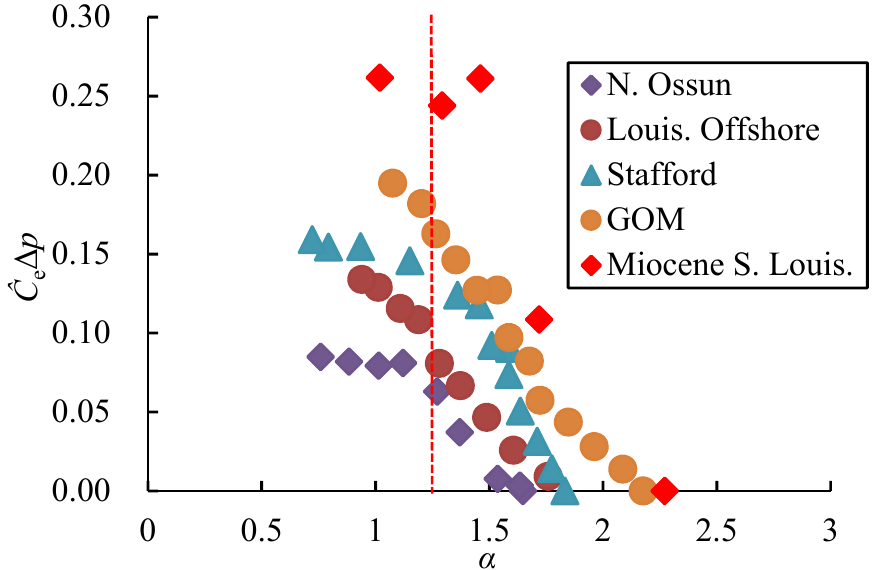
Figure 2. Relationship between the abnormally high-pressure effect and the pressure coefficient. The relationship between ˆC e ∆ p and α shows two different regular patterns in Figure 2: when the pressure coefficient was greater than 1.2, ˆC e ∆ p significantly changed with α and showed a good linear negative correlation (refer to Table 2 for the regression results); when the pressure coefficient was less than 1.2, the change in ˆC e ∆ p with α was slow. It can be seen that α = 1.2 should be taken as the cutoff point (position of inflection point C) between the abnormally high-pressured stage and the normal pressure stage in the pressure decline diagram. The gas reservoirs mentioned in this paper all had pressure coefficients greater than 1.2, so they are all exceptionally high-pressured reservoirs. Table 2. Gas reservoir relational regression equation of ˆC e ∆ p and α ( α ≥